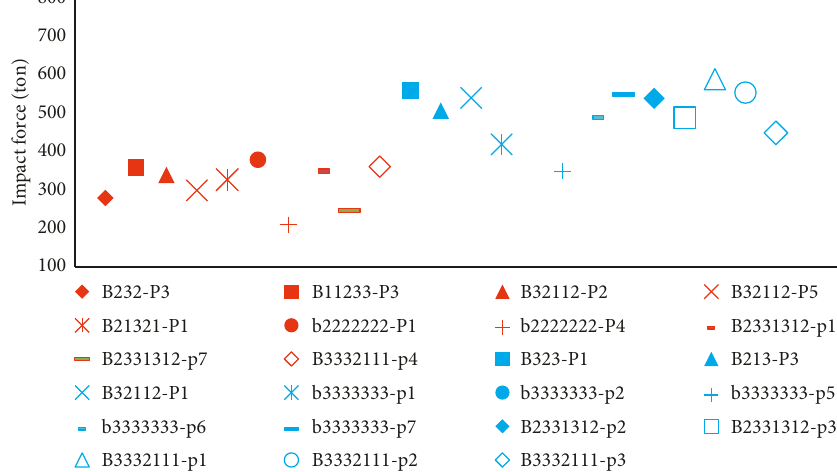
Figure 22: Impact forces for different types of piers (all red marks represent medium piers and all blue marks represent tall piers). ∗ B232-p3 means pier 3 of b232